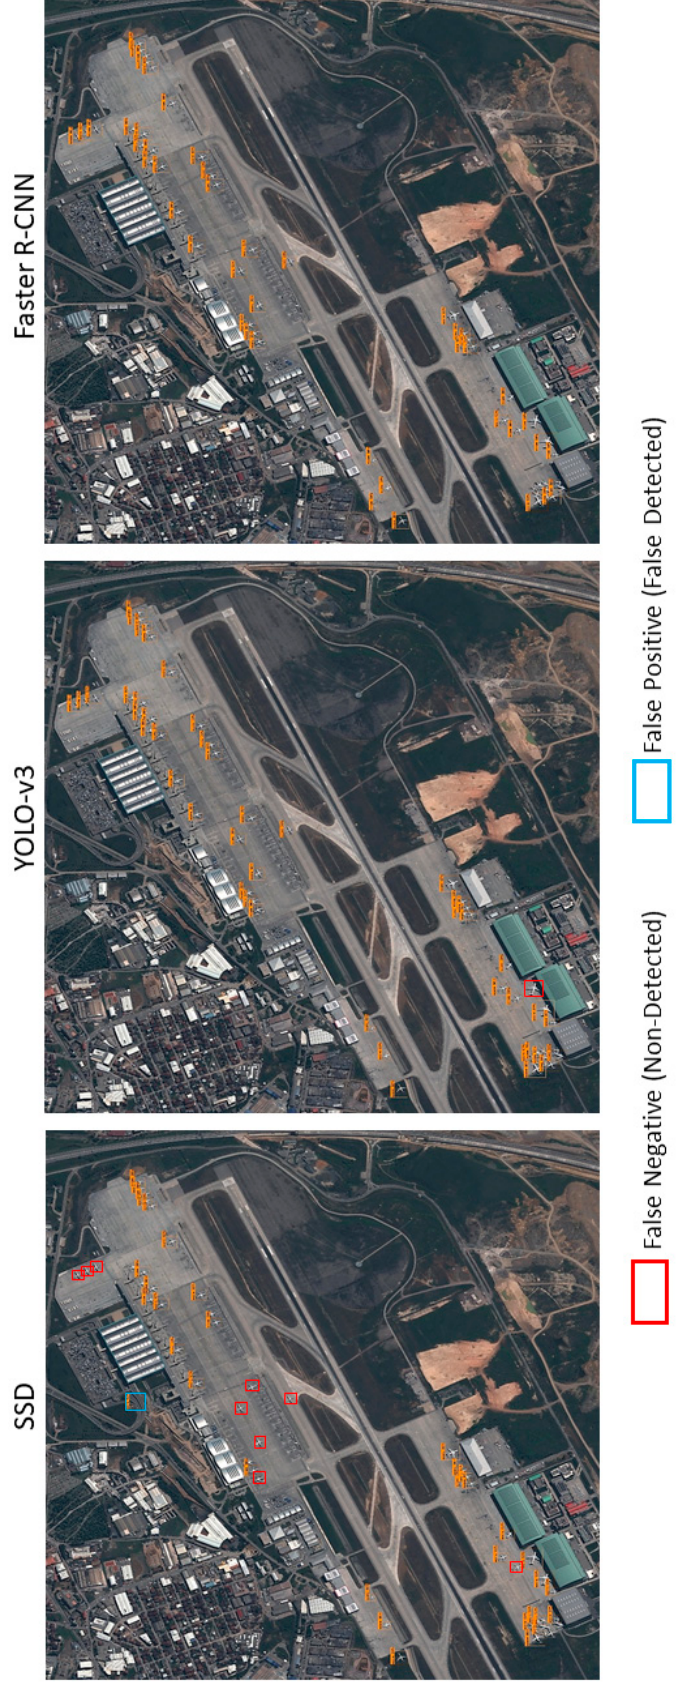
Figure A4. The aircraft detection results of Sabiha Gokcen Airport from Pleiades image data.